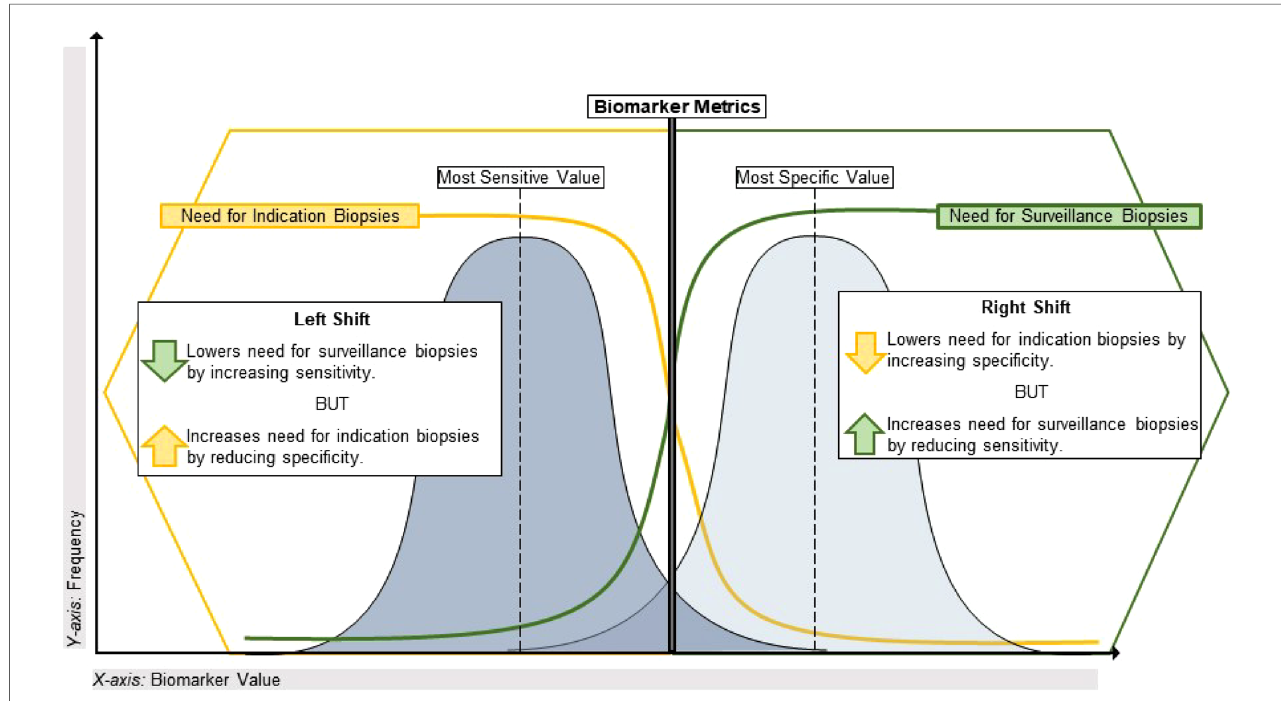
FIGURE 1 Using performance metrics to optimize application of biomarkers in transplant. This illustrates the sensitivity vs. speci fi city tradeoff for biomarkers of alloimmune injury as it pertains to the speci fi c clinical dilemma of maximizing the diagnostic yield from indication and surveillance biopsies. On the left side of the plot, a highly sensitive biomarker (often with a lower value on a continuous scale) will have a lower false negative rate and a high negative predictive value given the relatively low incidence of alloimmune injury discovered in universal surveillance biopsy programs during year-1 post-transplant. A biomarker with these characteristics could reduce the need for a universal surveillance biopsy program by identifying high-risk patients for early acute rejection that would likely be missed by current non-invasive standards such as creatinine. Conversely, on the right side of the plot a highly speci fi c biomarker (often with a higher value on a continuous scale) will have a lower false positive rate and a higher positive predictive value, given the greater incidence of clinical acute rejection discovered by for-cause/indication biopsies. With a short turnaround time, such a biomarker could reduce the need for indication biopsies in patients with allograft dysfunction if used to identify stable patients at low risk for clinical acute